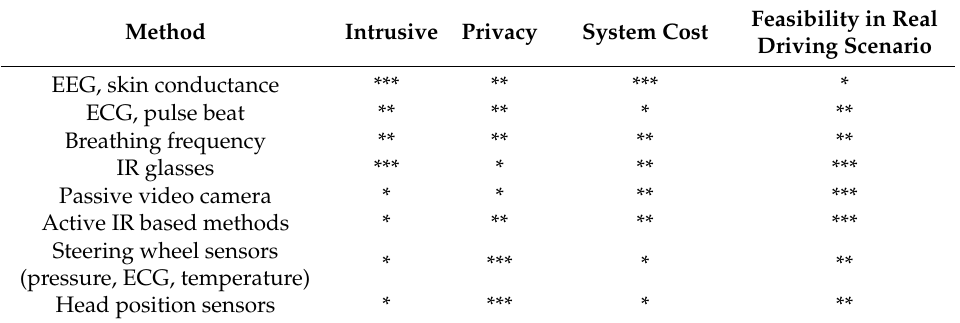
Table 1. Summary of driver current state monitoring methods, * LOW, ** MEDIUM, ***